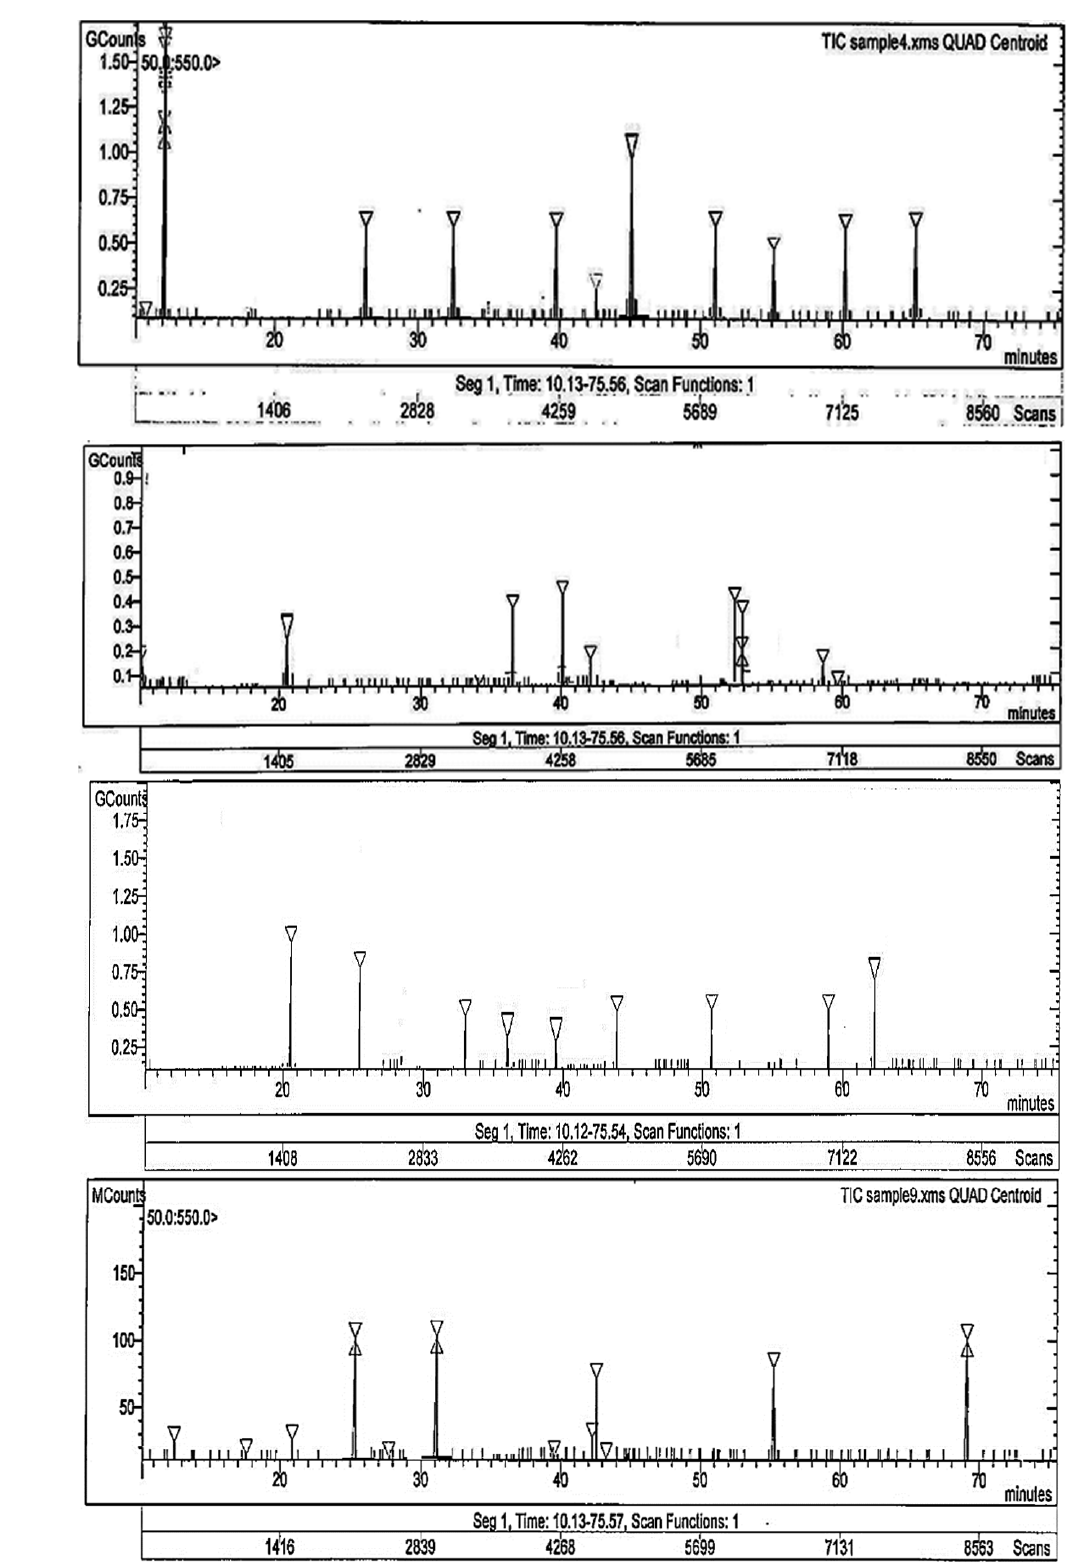
Figure 1. HPLC analysis of the phenolic compounds in the different organs as well as the solid distillation wastes of Taif’s rose collected from Al-Shafa highlands in Taif City, Saudi Arabia.